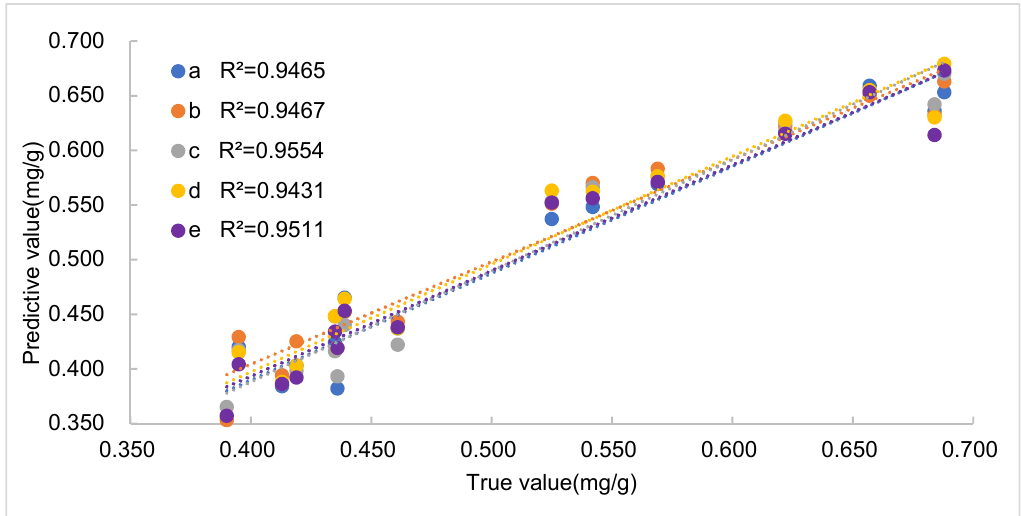
Figure 6. Multilayer perceptron (MLP) models with different characteristic features were established to predict the results. a: All color features; b: Principal component factors extracted from all color features by principal component analysis; c: Average features of all colors; d: Principal component factors extracted from principal component analysis of color average features; e: R_mean, G_mean, B_mean, and